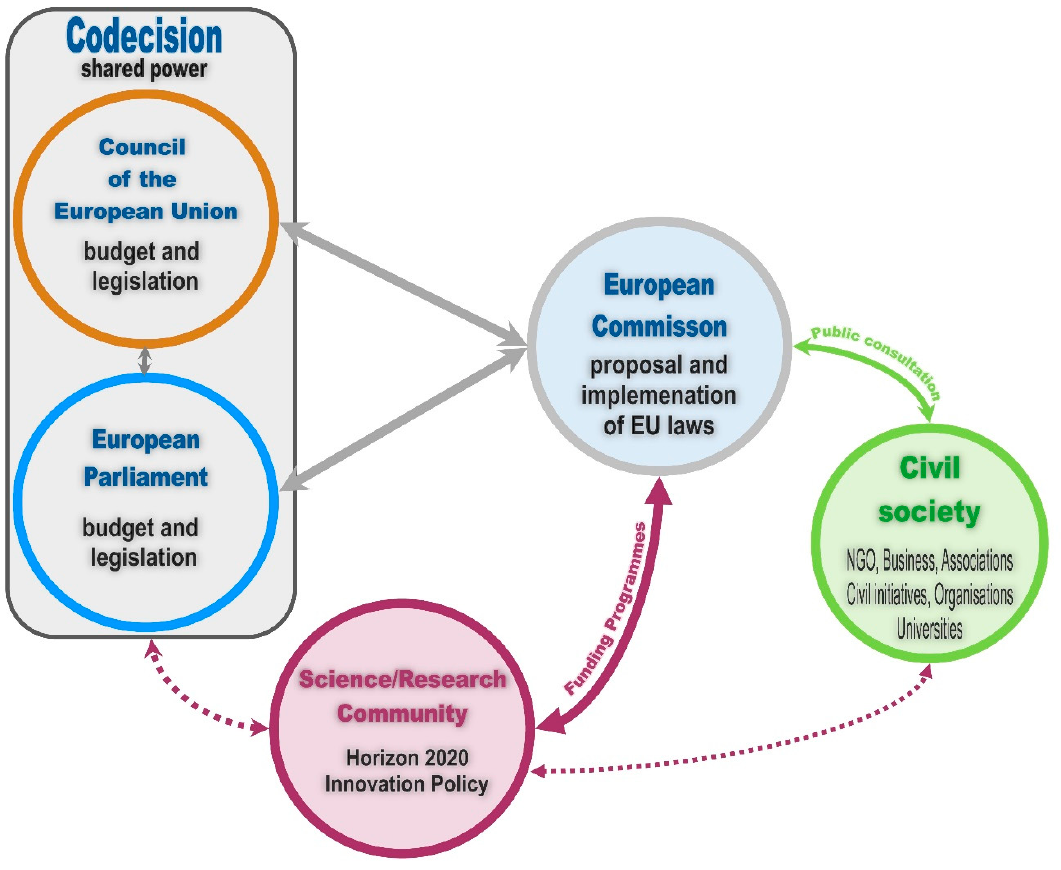
Figure 3. The entry point for the science/research community funded by the Horizon 2020 program’s call for a decision making-procedure of the EU.